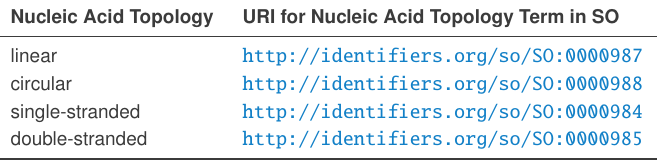
Table 3: Sequence Ontology terms to encode DNA or RNA topology information in types properties of a ComponentDefinition .